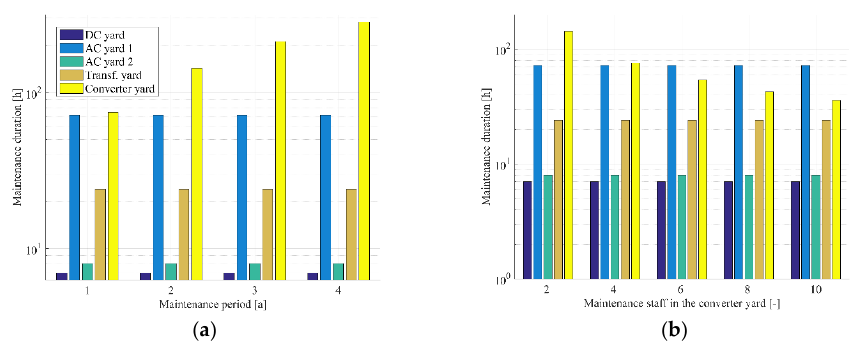
Figure 6. Maintenance time ( a ) for the different maintenance areas of the HVDC system over different maintenance periods and ( b ) for a two-year maintenance period over different number of maintenance staff in the converter